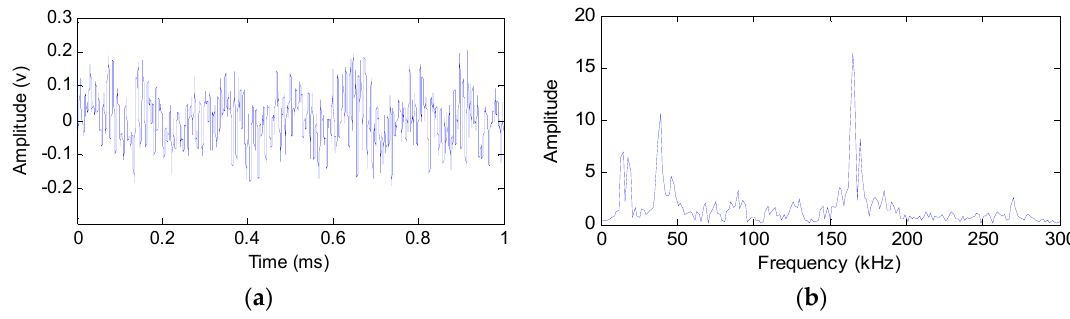
Figure 6. Time domain waveform and frequency spectrum of Sensor 1. ( a ) Time domain signal waveform; and ( b ) the frequency spectrum.